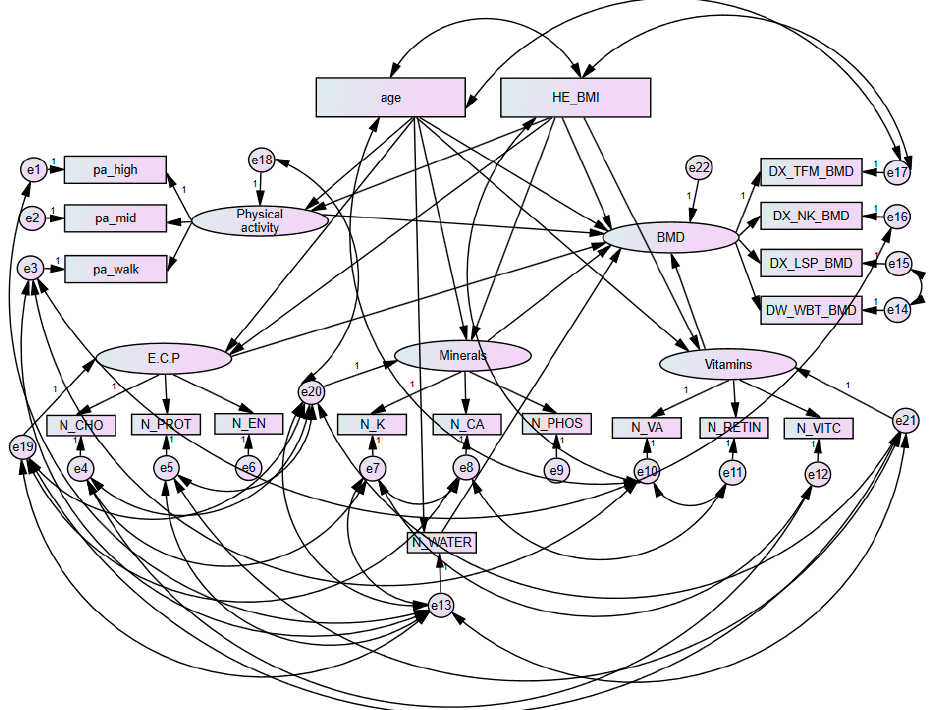
Figure 2. Results of direct pathways and total pathways with age, BMI, physical activity, and nutrient intakes in premenopausal women with bone mineral density. Errors are presented with e1, e2, e3, e4, e5, e6, e7, e8, e9, e10, e11, e12, e13, e14, e15, e16, e17, e18, e19, e20, e21 and e22. BMD, bone mineral density; N_CA, calcium; N_CHO, carbohydrate; N_EN, energy; E.C.P., energy, carbohydrates, and protein; DX_NK_BMD, femoral neck bone mineral density; pa_high, high intense phys-